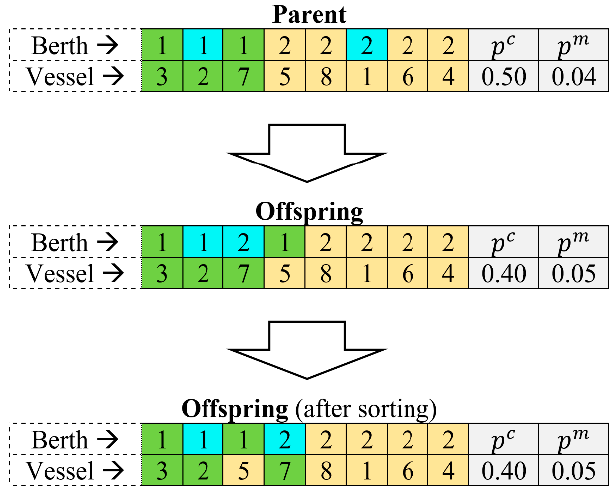
Figure 6. An example of the SAEA mutation operation: insert + floating point. Algorithms 2018 , 11 , x FOR PEER REVIEW